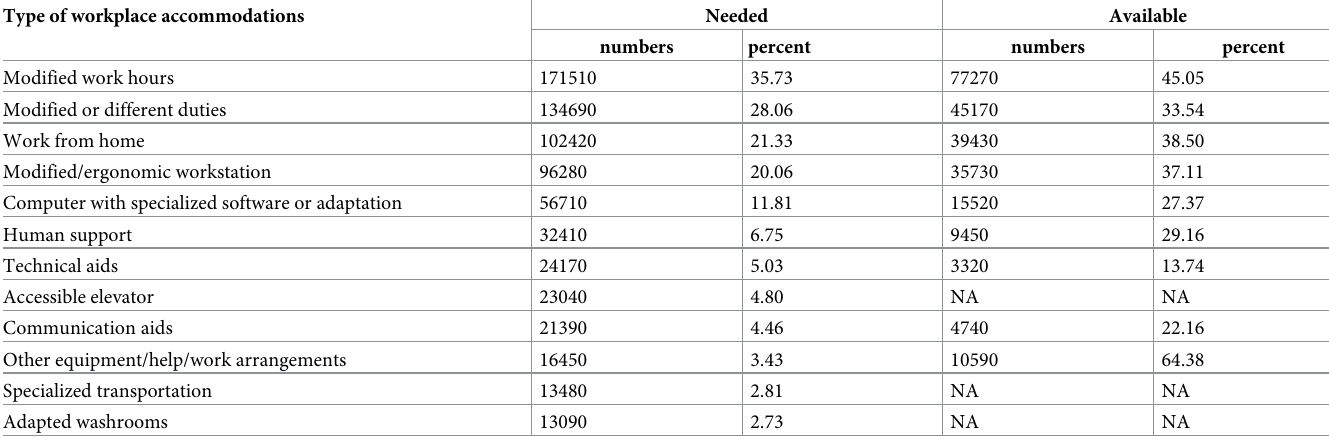
Table 4. Workplace accommodations needed and provided to employees with seeing disabilities (25–64 years), 2017 (N =